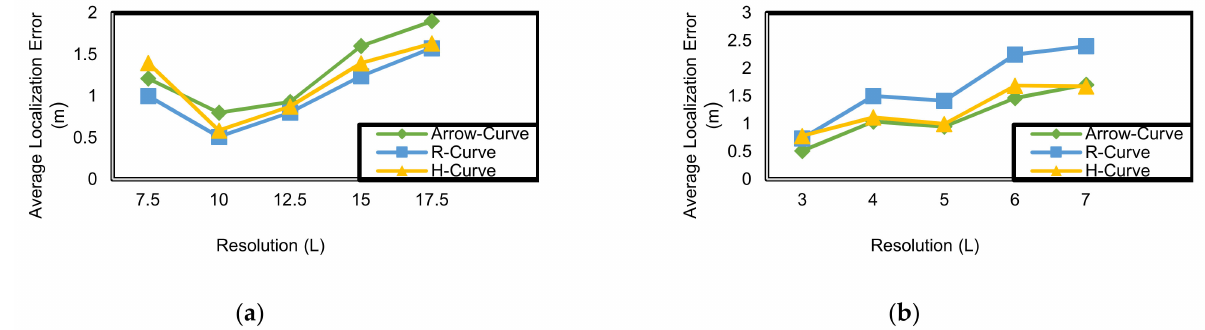
Figure 18. Average localization error (m) corresponding to resolution (L) in Arrow-Curve model, R-Curve model, and H-Curve (outdoor environment): ( a ) (outdoor environment); ( b ) (indoor